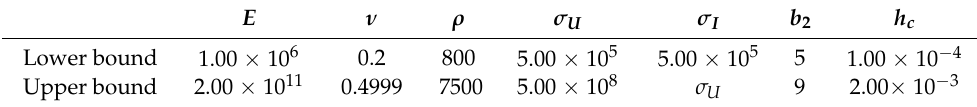
Table A1. Bounds used for each of the input parameters for the global sensitivity